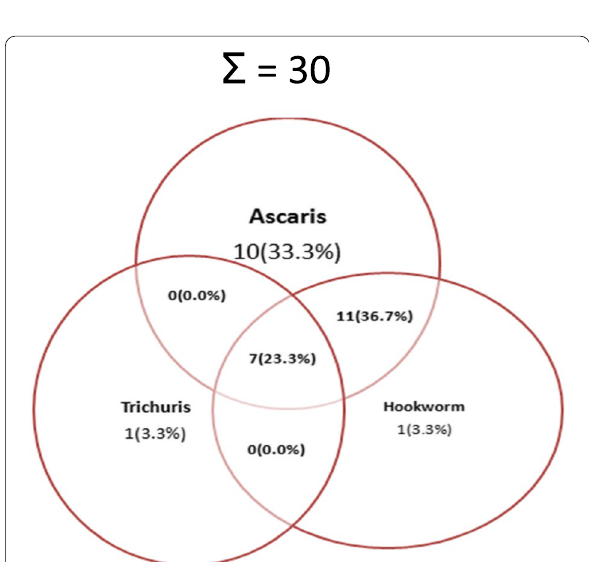
Fig. 1 Parasite specific combination prevalence in the urban community